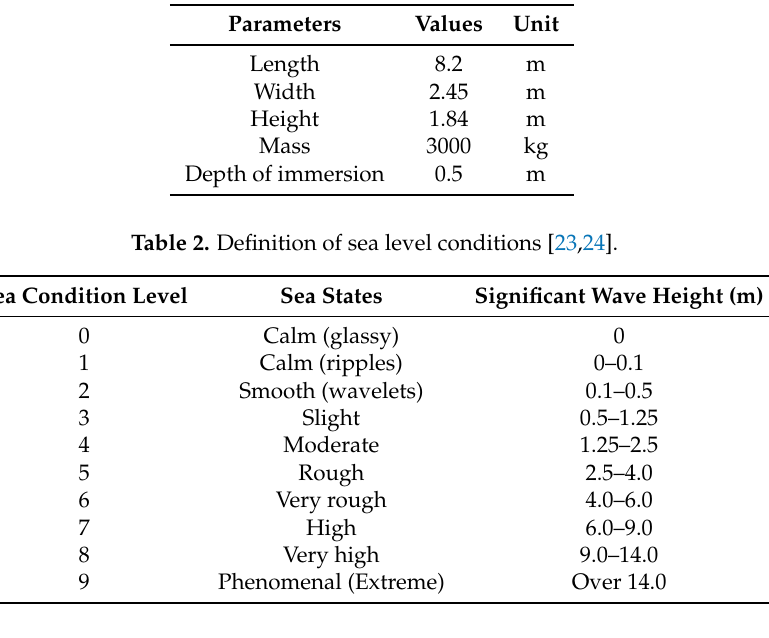
Table 1. Specifications of “Jinghai VII” USV.